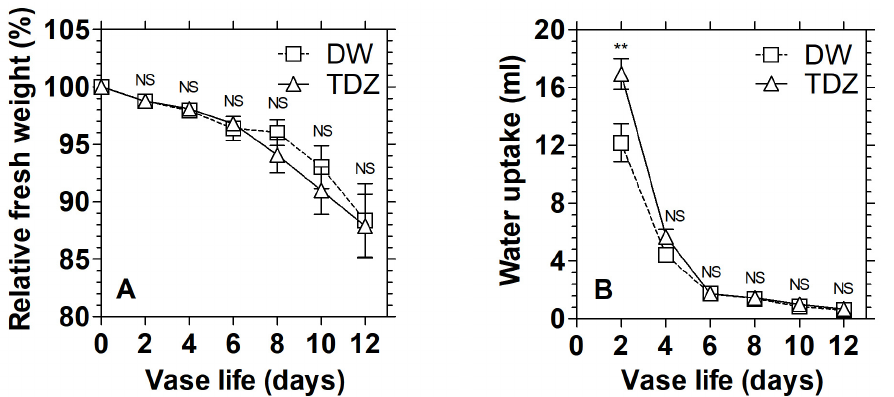
Figure 7. Effect of TDZ and MAP on fresh weight ( A ) and water uptake ( B ) of D. solida leaves after 1-week storage. Leaves were pulsed with 10 μ M TDZ and distilled water (DW; control), then packed in BOPP bag, and stored at 10 °C under cool-white, fluorescent lights for 12 h/d for 1 week. After storage, ferns were transferred to distilled water in a controlled environment room for the vase period. Asterisks (*) indicate significant differences between the two treatments after storage ( t -test; ** p < 0.01, NS not significant).